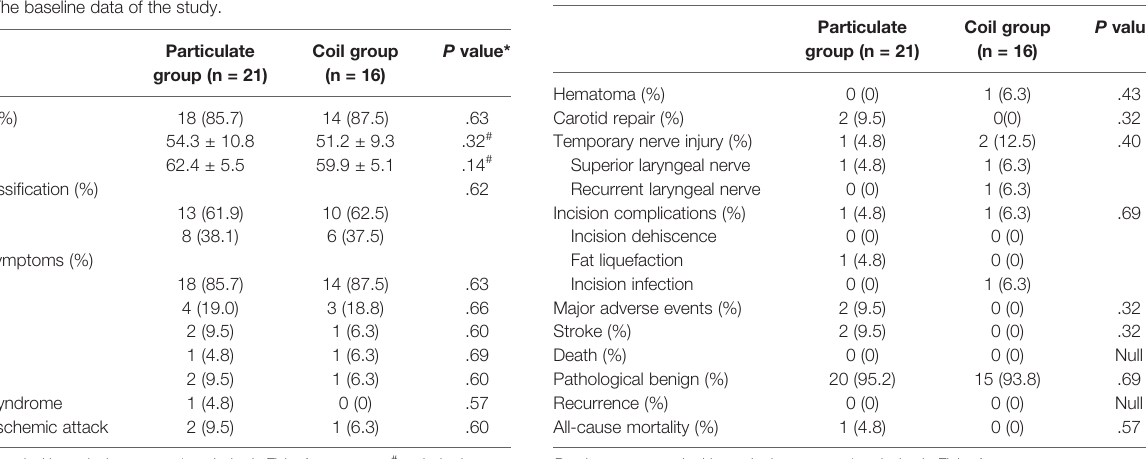
TABLE 3 | Complication and long-term outcomes in both